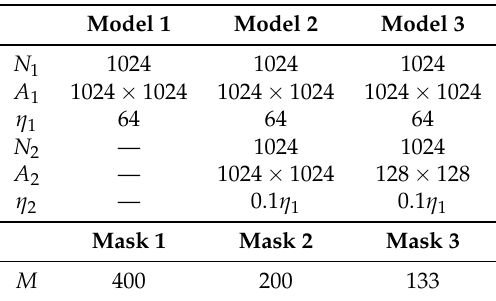
Table 1. Simulation parameters for models 1, 2 & 3 and for the masks. Nomenclature, with subscripts 1 and 2 indicating fast and slow particles, respectively: N 1,2 : number of particles; A 1,2 : initial area (in pixels) on which the particles are positioned; η 1,2 : diffusion constant.